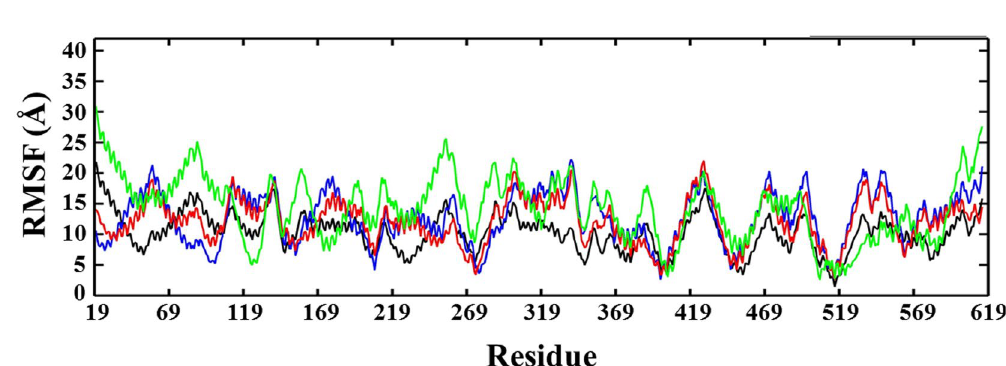
Figure 4. RMSF plots of ACE2 and docked complexes, ACE2-NF1, ACE2-NF12, and ACE2-NF13.